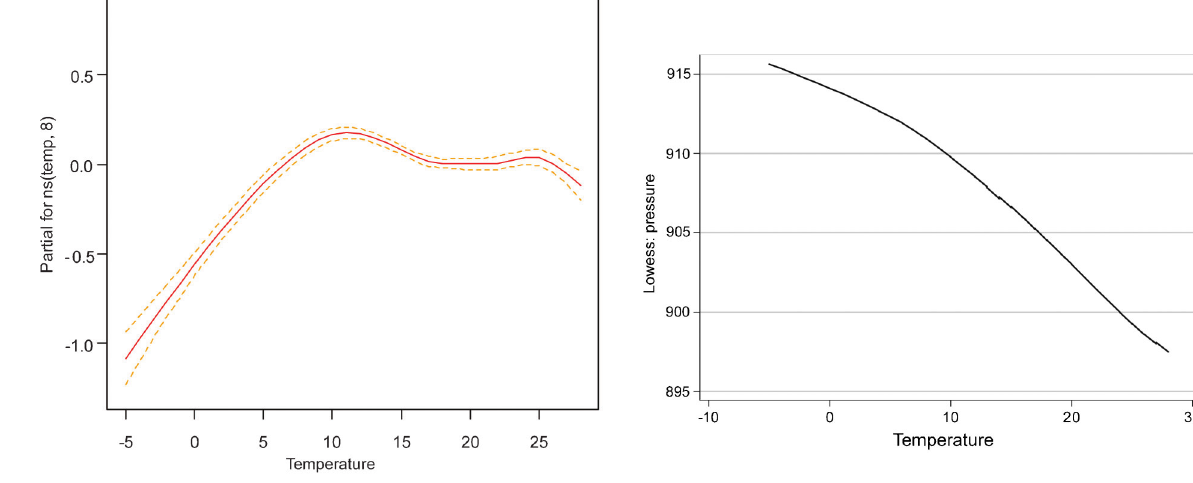
Figure 4. Atmospheric pressure and air temperature linear